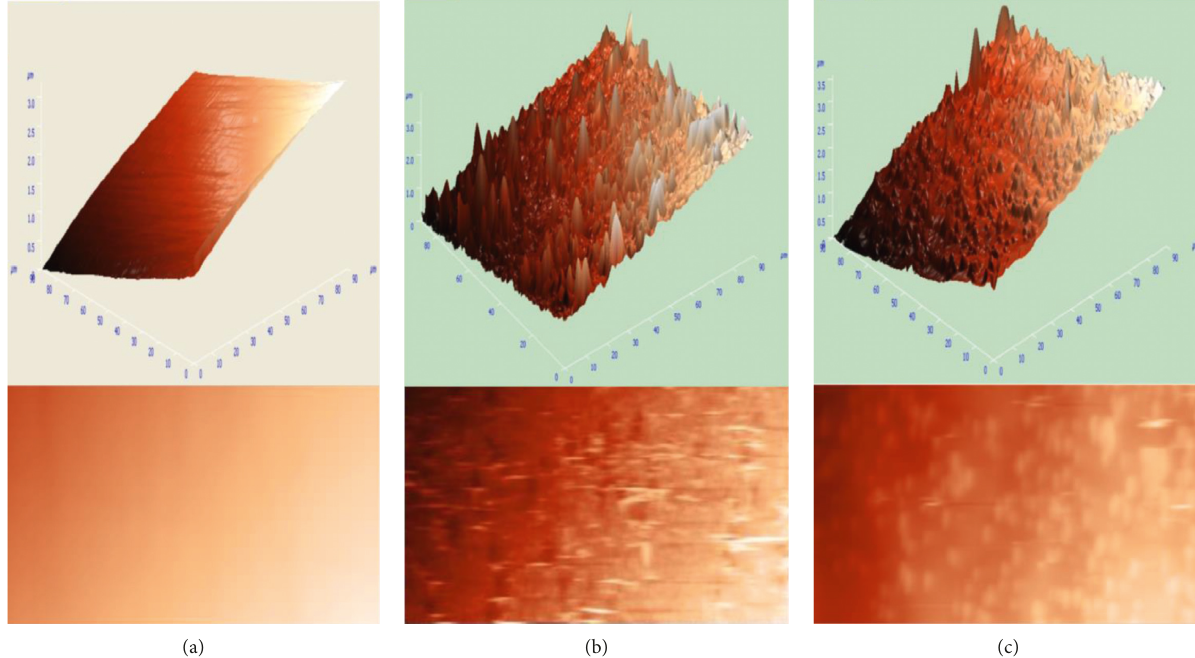
Figure 5: AFM images show the characteristic surface morphology form GCE (a); PtNFs/GCE deposited at the potential of − 0.2 V (b); 0.2 V